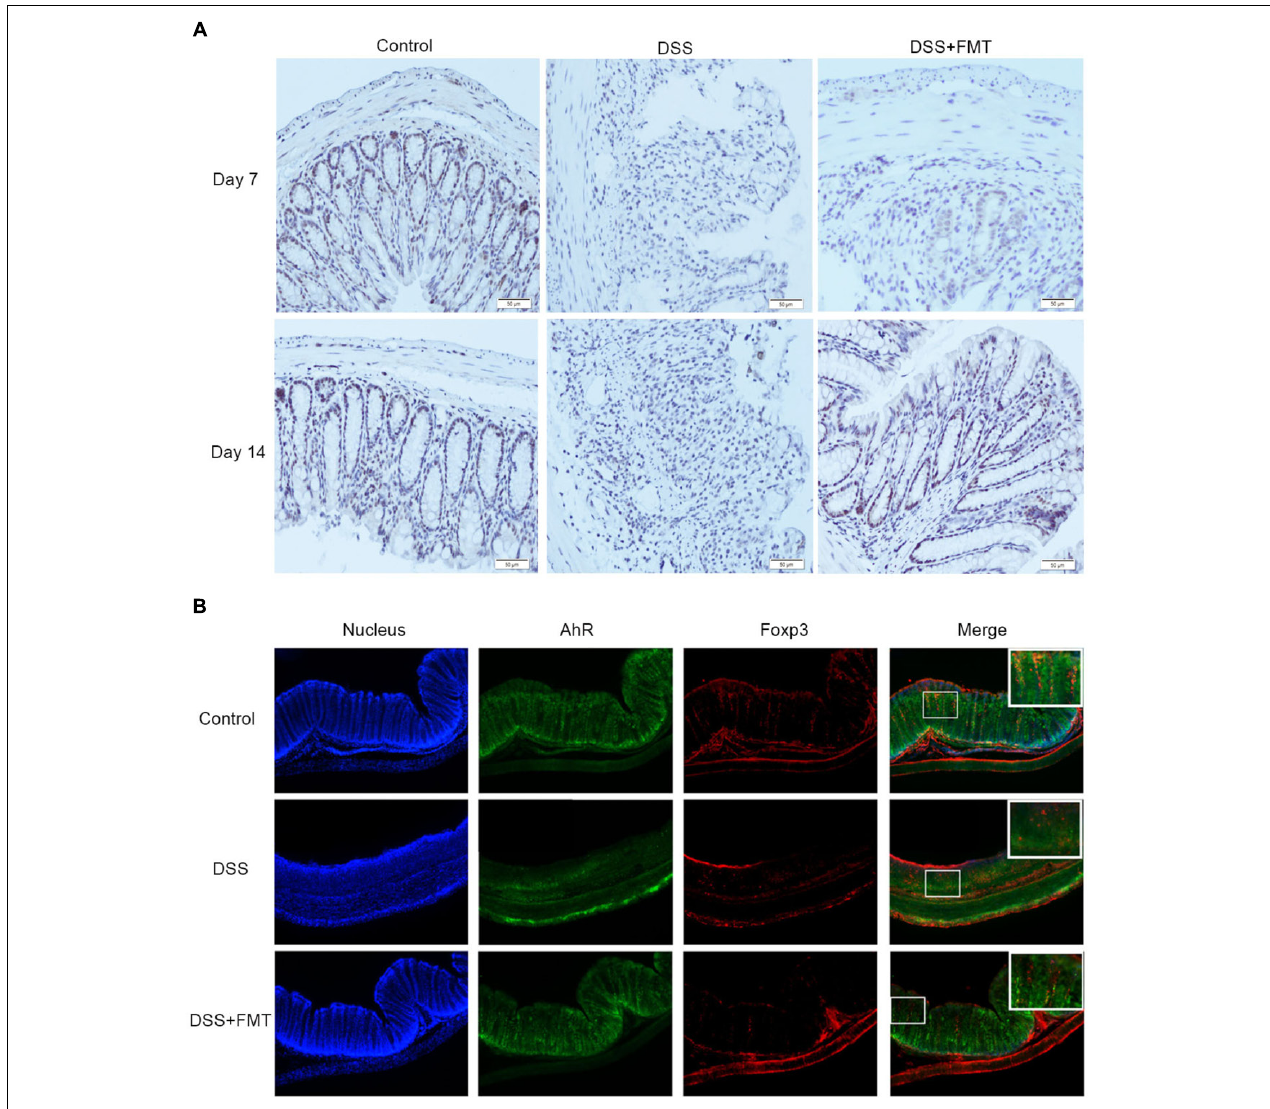
FIGURE 5 | Compared with that in the control group, decreased AHR expression in colon tissues of mice was induced by DSS and detected by immunohistochemistry (A) , Representative colon images at the indicated time point in each group. Scale bars = 50 µ m. Representative example of an immunofluorescence double staining of Foxp3 (Red) and AhR (Green) in colon tissues (B)